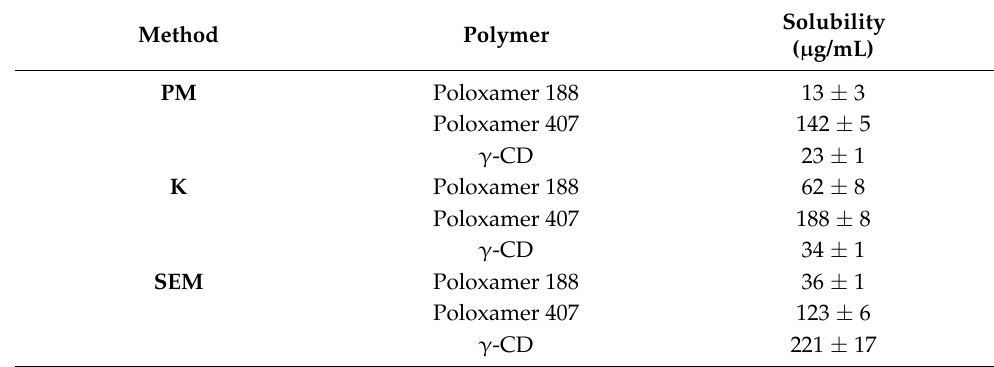
Table 3. Solubility of OA in hydrophilic polymers, using 2:1 drug-to-polymer weight ratio and differ- ent preparation methods (PM: physical mixture; K: kneading; SEM: solvent evaporation